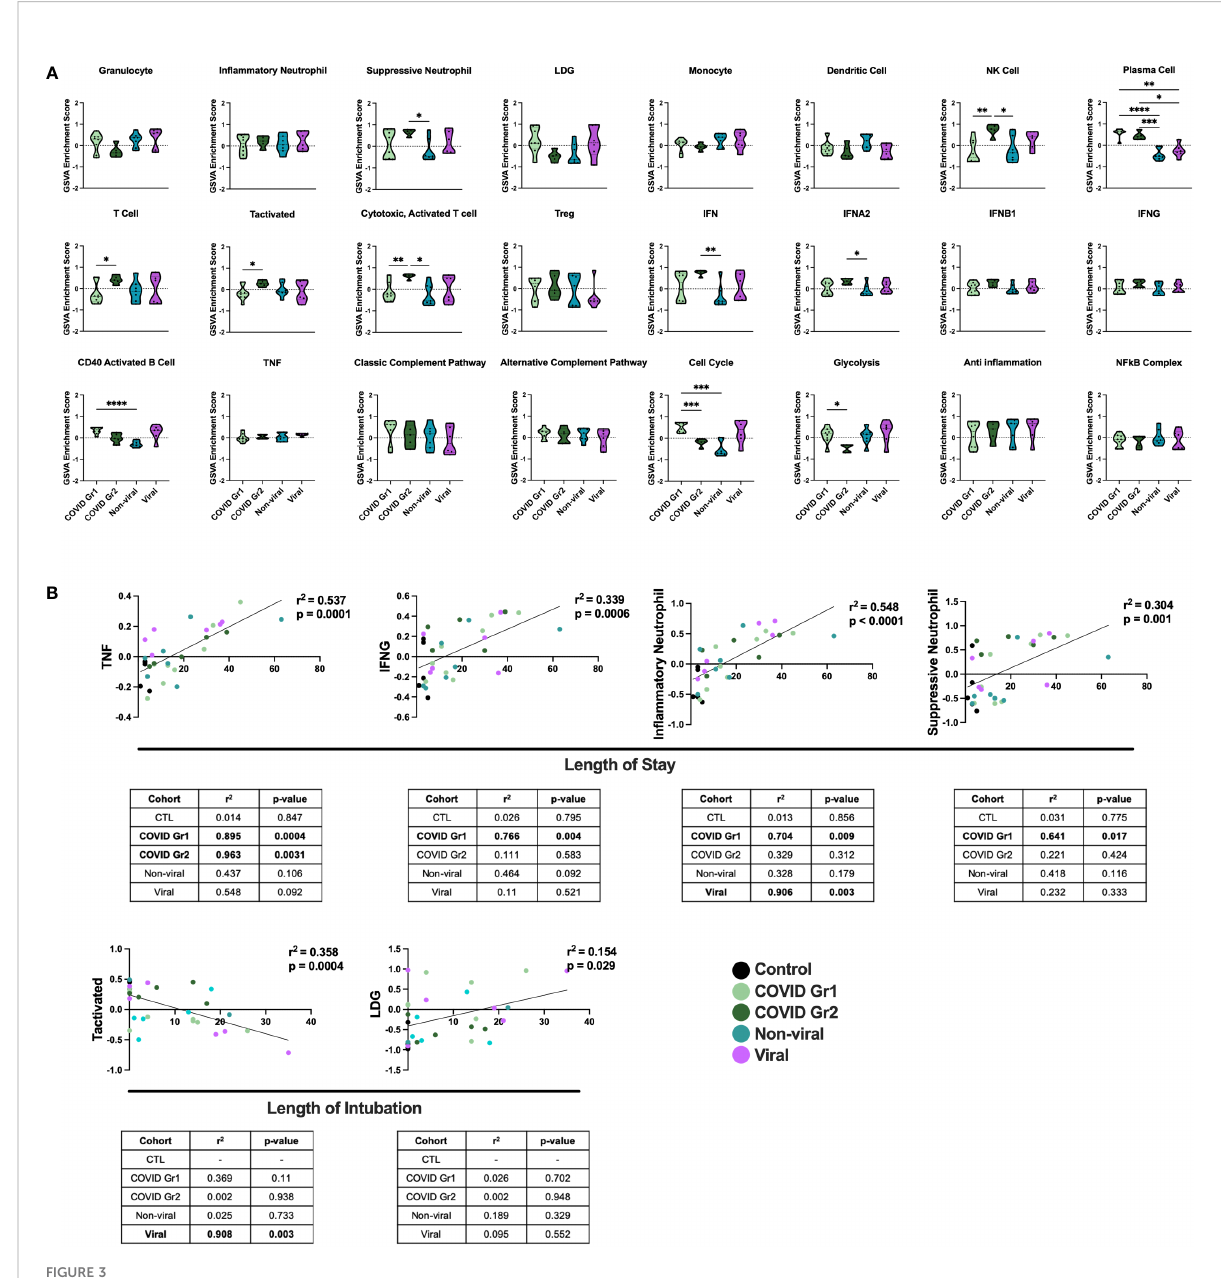
FIGURE 3 Conserved and unique immune signatures identify ICU patients with different sources of AHRF and vary in correlations with clinical data. (A) Individual sample gene expression from COVID Group 1, COVID Group 2, Viral, or Non-viral AHRF ICU patient cohorts was analyzed by GSVA for enrichment of immune cell and pathway gene signatures. Enrichment scores are shown as violin plots. *p < 0.05, **p < 0.01, ***p < 0.001, ****p < 0.0001. (B) Multivariable linear regression analysis of immune cell gene signatures signi fi cantly correlated with clinical data from Control, COVID Group 1, COVID Group 2, Viral, and Non-viral AHRF ICU patient cohorts. Combined cohort correlations and p-values are displayed in the linear regression plots while individual cohort correlations and p-values are displayed in the tables below. Correlations with p < 0.05 were considered signi fi